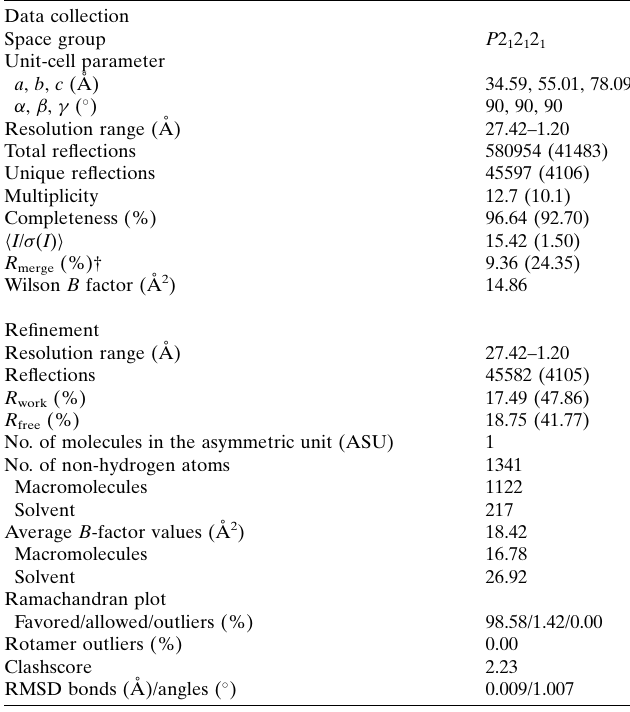
Table 1 Data-collection and refinement statistics. Values for the outermost resolution shell are in